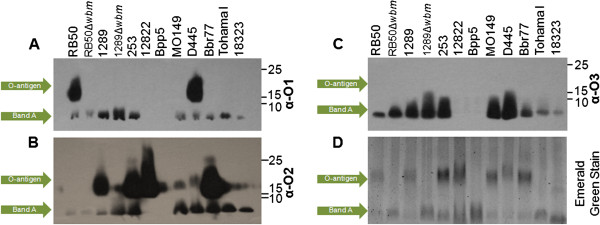
O-antigen type of the Bordetella species is either O1, O2, or O3. (A-C) C57BL/6 mice were inoculated with 104CFU B. bronchiseptica strains RB50 (O1), 1289 (O2) or MO149 (O3), and serum was collected 28days later. LPS or LOS was purified from the indicated strains and were probed with serum against the aforementioned bordetellae. (D) LPS or LOS was stained with Emerald green; O-antigen and Band A are denoted.